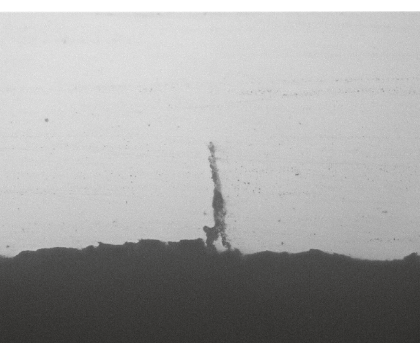
Figure 9: Energy spectrum.